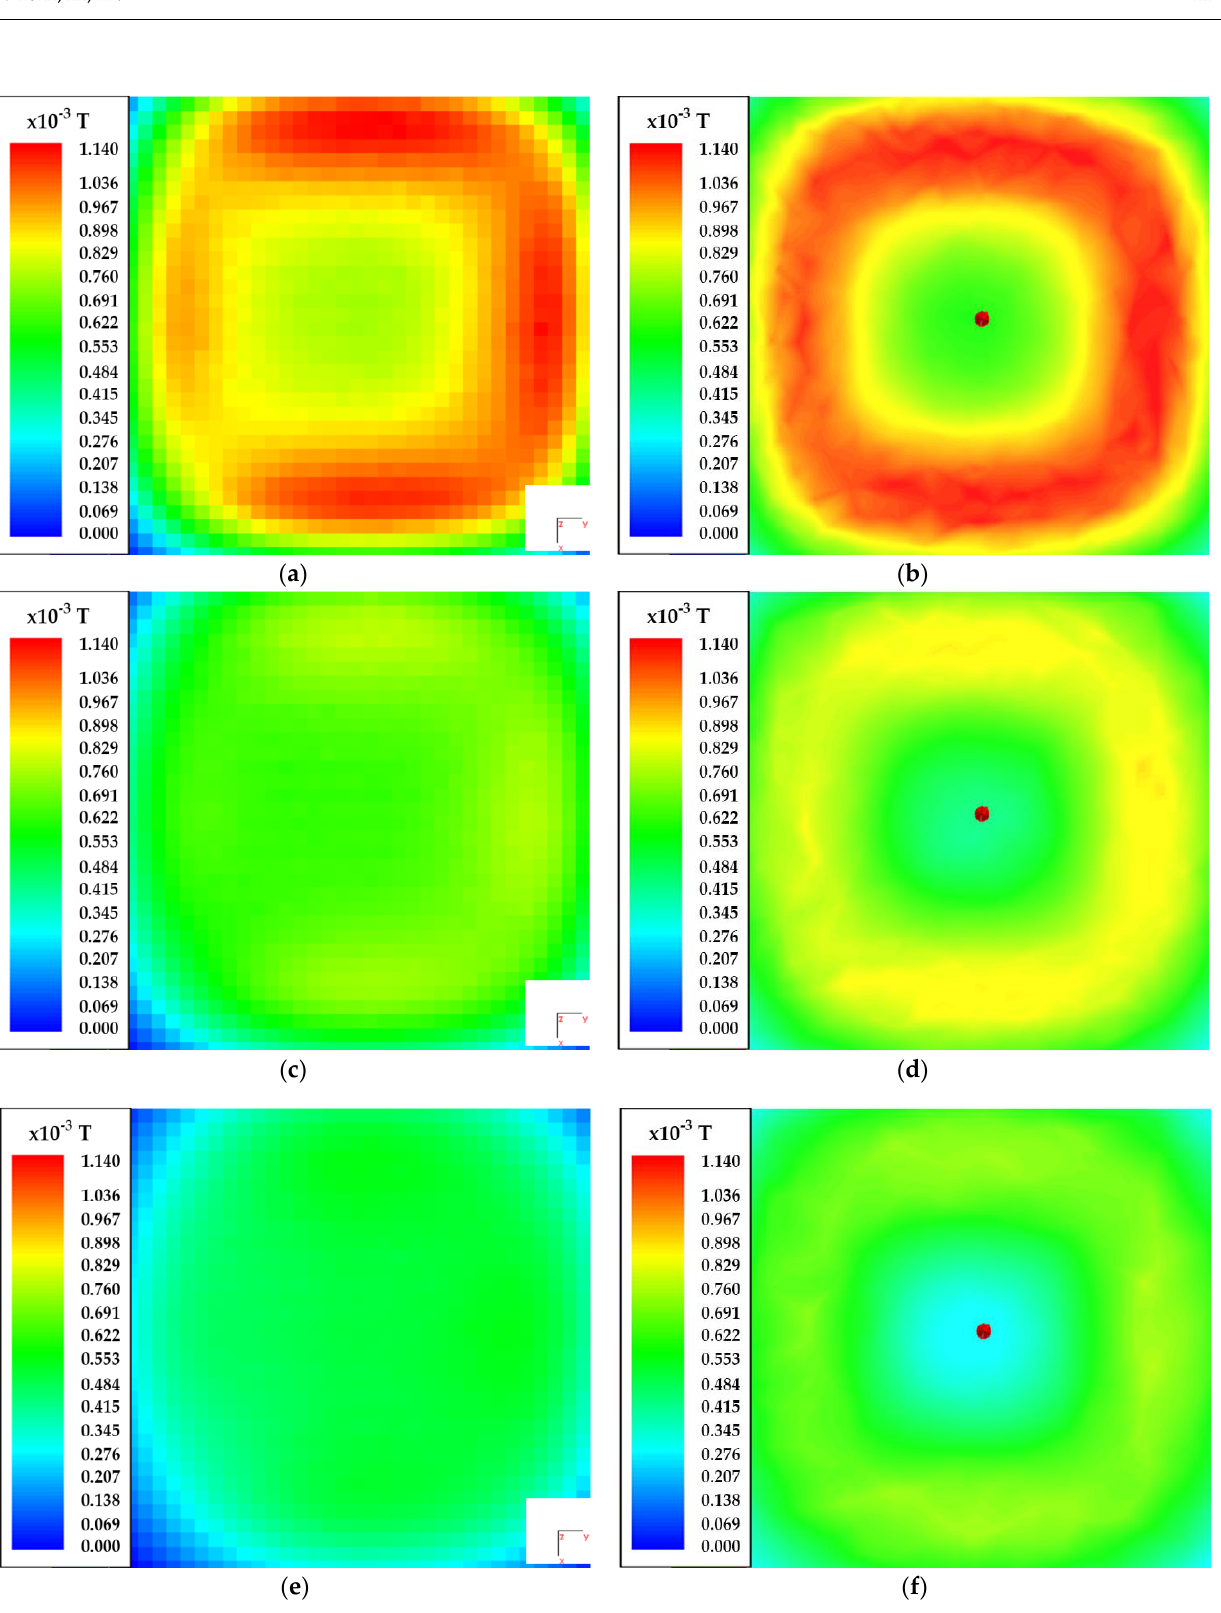
Figure 20. Magnetic flux density measurement of the square spiral transfer pad: ( a ) measured absolute value of magnetic flux density at z = 15 mm; ( b ) simulated absolute value of magnetic flux density at z = 15 mm; ( c ) measured absolute value of magnetic flux density at z = 20 mm; ( d ) simulated absolute value of magnetic flux density at z = 20 mm; ( e ) measured absolute value of magnetic flux density at z = 25mm; ( f ) simulated absolute value of magnetic flux density at z = 25 mm.